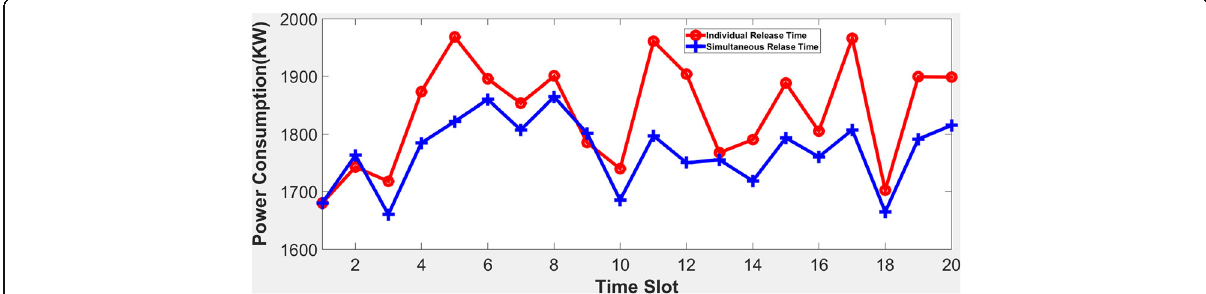
Fig. 4 Optimal power consumption as a function of time for individual and simultaneous VM release with parameter ρ h =0.3 and migration cost G r =0.3